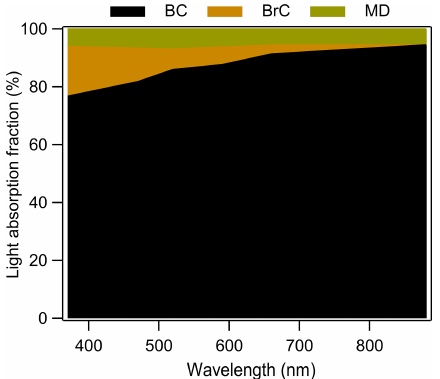
Figure 3. Light absorption fractions of BC, BrC and MD in the to- tal light-absorbing aerosols. BC: black carbon; BrC: brown carbon; MD: mineral